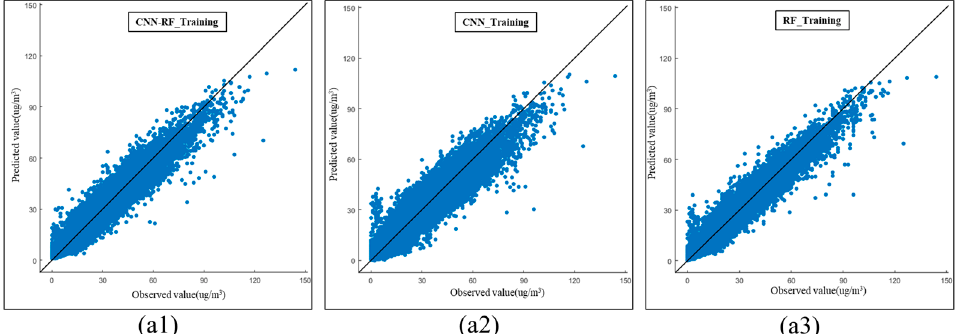
Figure 4. Scatterplots of predictive PM2.5 concentration models. ( a1 ) Prediction scatterplot of CNN–RF model with training data. ( a2 ) Prediction scatterplot of CNN method with training data. ( a3 ) Prediction scatterplot of RF method with training data.